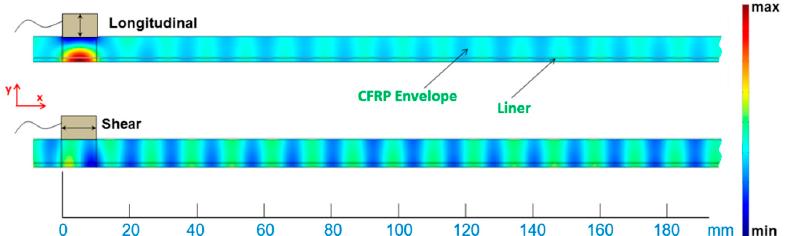
Figure 6. Typical FEM simulation results for longitudinal ( top ) and shear ( bottom ) mode transducer types shown on the same scale, for excitation frequency of 200 kHz.